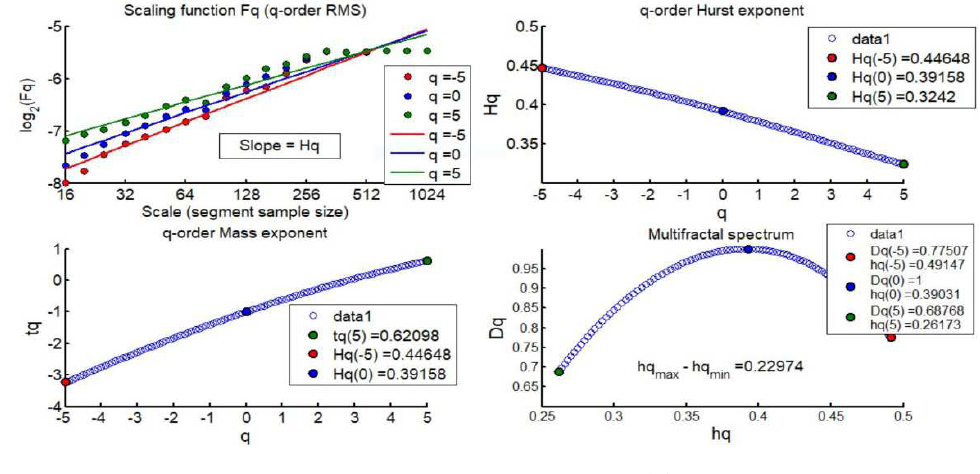
Figure A4. Hurst exponent value Hq (5) in 2014